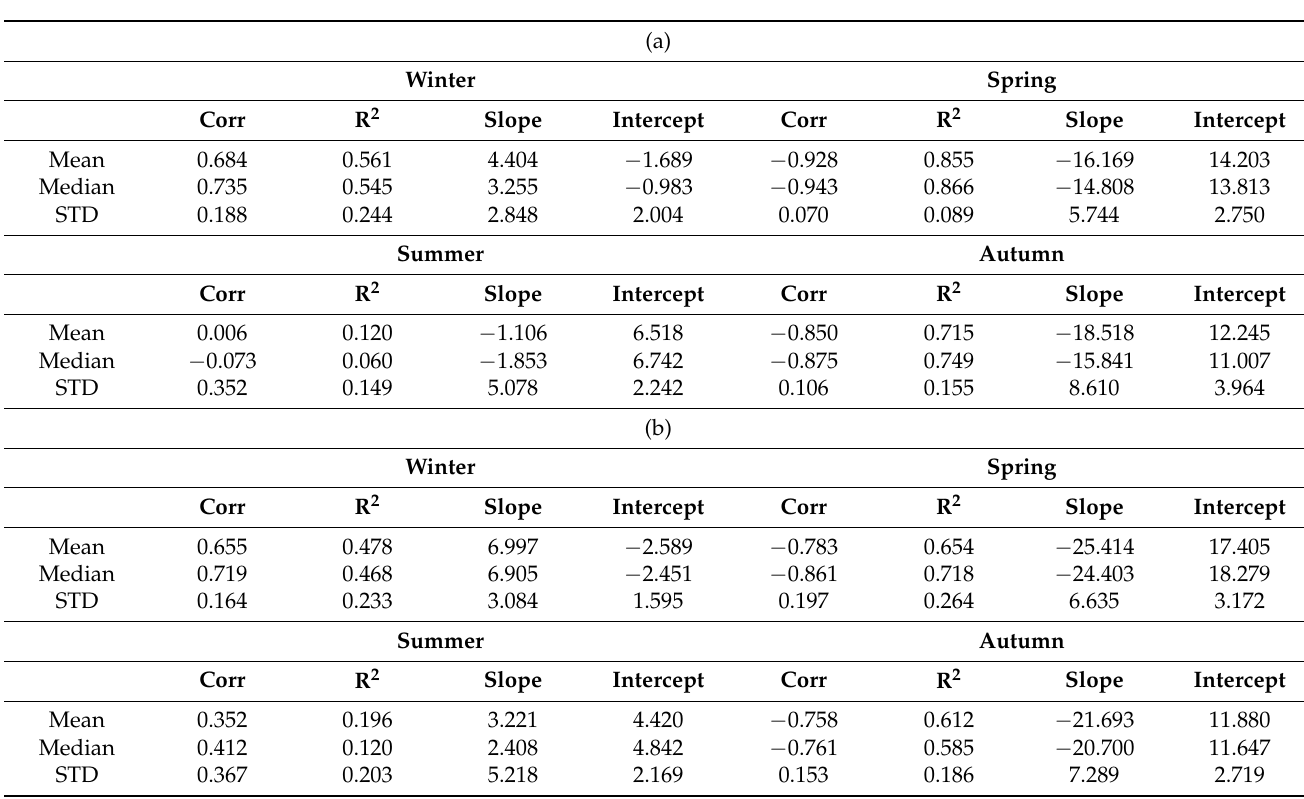
Table 2. (a) Mean, median, and standard deviation (STD) of the correlation coefficients (Corr), coefficients of determination R 2 , and the slope of the fitting line, and its intercept, for the Patern ò case study. (b) Mean, median, and standard deviation (STD) of the correlation coefficients (Corr), coefficients of determination R 2 , and the slope of the fitting line, and its intercept, for the Busachi case